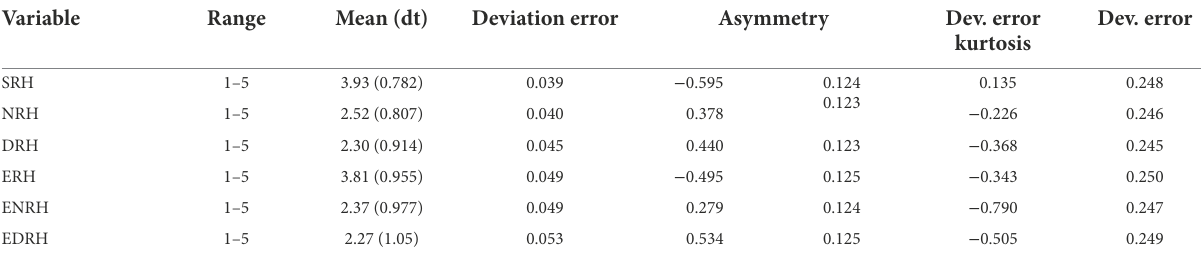
TABLE 16 Values descriptive of the validation sample ( n = 400).